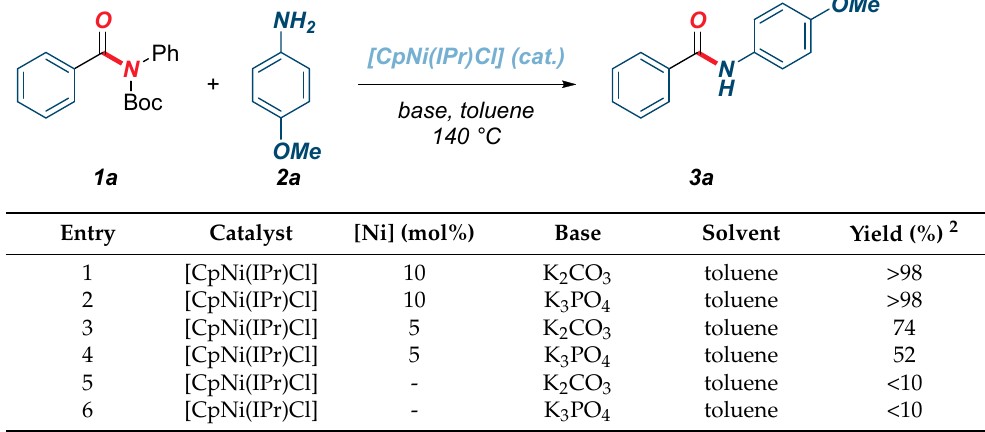
Table 1. Optimization of the transamidation of amide 1a using [CpNi(IPr)Cl]. 1